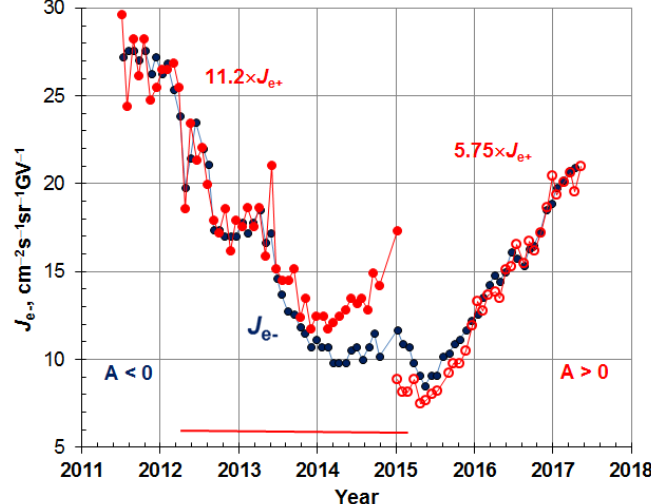
Figure 5. Time dependences of the electron (dark points) and positron (red points) intensities with rigidities R = 1.0–1.2 GV [9]. On the ascending branch of solar activity (2011–2015), the positron intensity was normalized to the electron one over a time interval (2011.5–2013.3): J e- = 11.2 J e+ . The same was done for the descending branch of solar activity (2015–2017): J e- = 5.75 J e+ . The time interval for normalization was (2017.1–2017.4). The horizontal straight red line shows the time interval when inversion of the solar polar magnetic field took place [12,13].